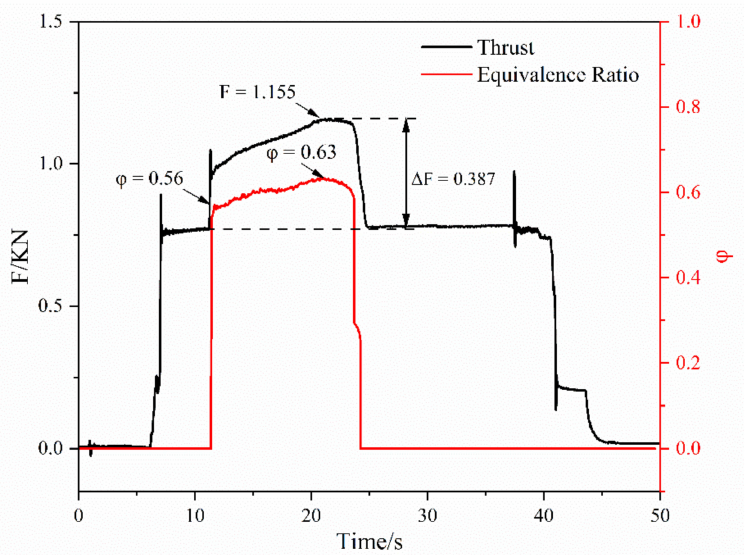
Figure 10. Evolution of the equivalence ratio and thrust during the